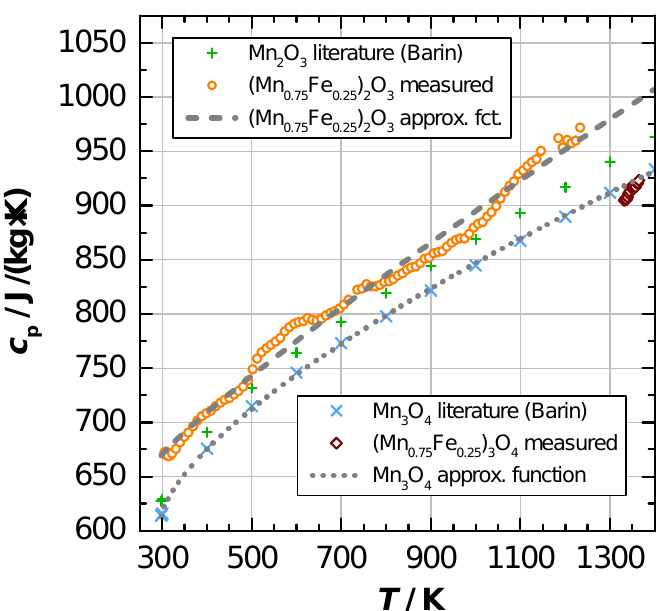
Figure A1. Specific heat capacity of manganese-iron oxide: Measured and approximated values for (Mn 0.75 Fe 0.25 ) 2 O 3 and (Mn 0.75 Fe 0.25 ) 3 O 4